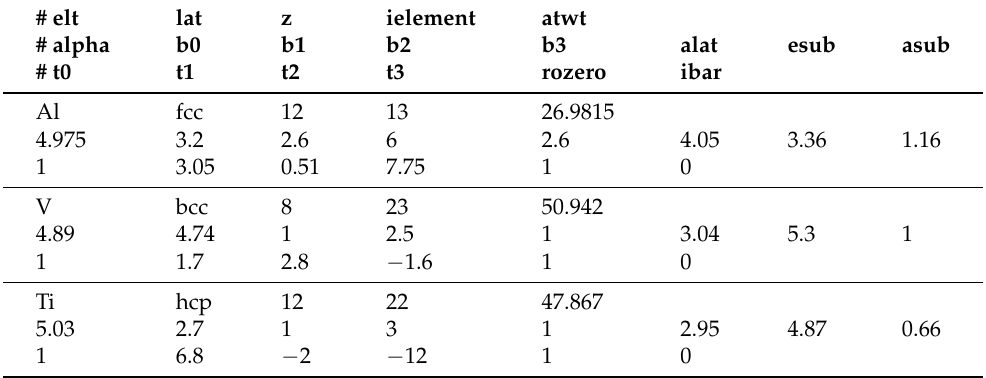
Figure 1. ( a ) Image (obtained with OVITO [43]) of the initial state of sintering of 3 particles with HCP crystal structure ( α phase). Diameters of the particles 1 to 3 (from left to right): 1st 14 nm, 2nd 12 nm, and 3rd 16 nm. The colours show Ti (red), Al (yellow), and V (blue). ( b ) Distances between particles 1–2 (blue), 2–3 (red) and 1–3 (black) as a function of time during first 0.39 ns of sintering. Distance between pairs 1–2 and 2–3 is increased by 9 nm to be in scale with the distance for the pair 1–3. Table 1. Parameters of the MEAM force field used in MD